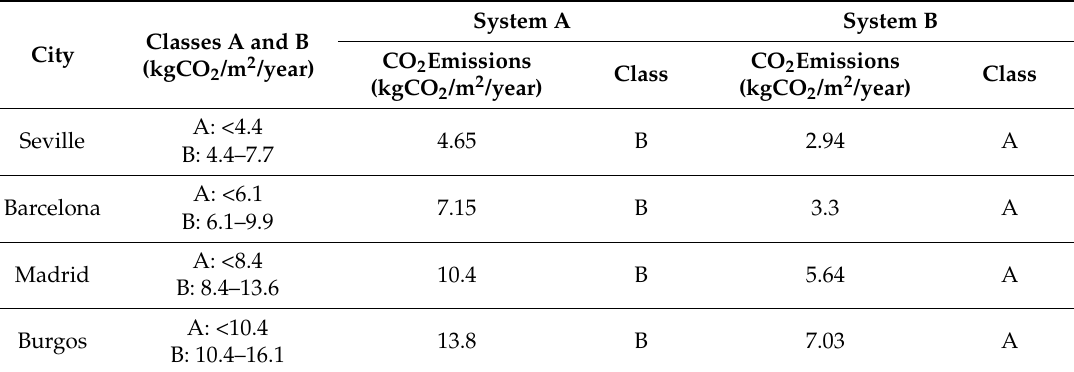
Table 6. Total CO 2 emissions and building energy performance